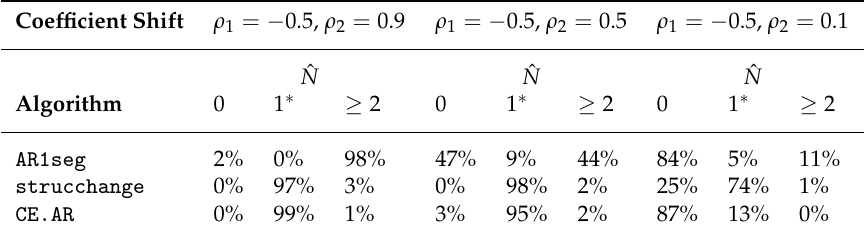
Table 4. The estimated number of change-points under scenario